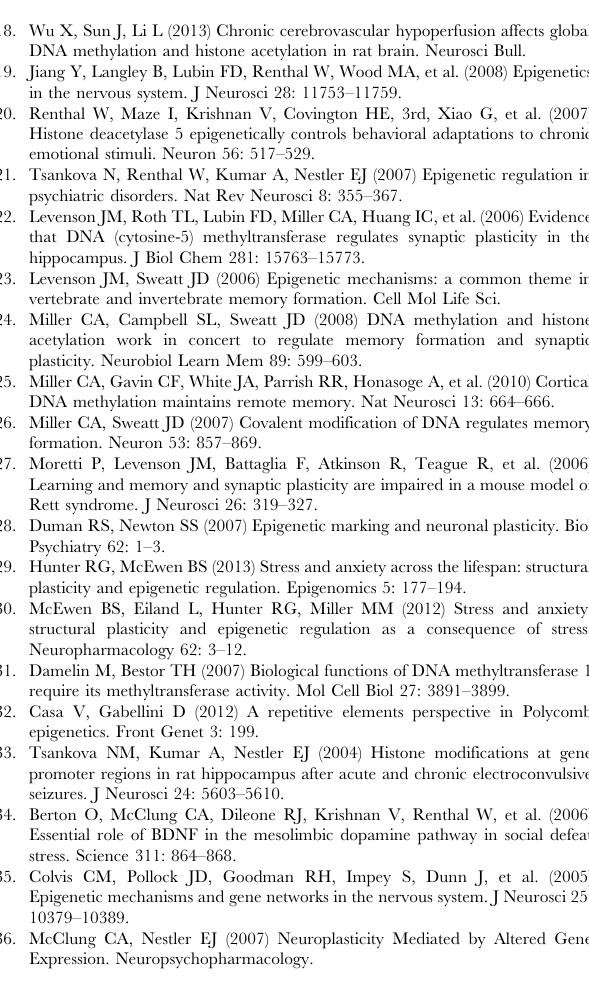
samples per group). The same samples were evaluated with Western blot detection of AcH3 levels. In all cases, results from Western blot agreed with those from flow cytometry. Figure S2 Technical replication of flow cytometry measurements. After performing flow on 20 samples from the hippocampus, samples were stored overnight and re-run. Mea- surements were highly correlated across flow cytometry runs (Pearson R= 0.95, p , 0.0001). Table S1 Spearman correlations of open-field behav- ioral measures across testing days. Table shows the Spearman-r values for the correlations between five open-field measures (percent distance in the center, total distance in the center, time spent in the center, entries into the center, and total distance travelled) on testing day 1 with behavioral measures from 2 subsequent testing days. Sessions 1 and 3 were conducted in direct light and session 2 was done in the dark to make the testing environment less anxiogenic. Results show there were significant correlations between nearly all measures on subsequent testing days and the behavior of mice on testing day 1. Results indicate that day 1 measurements predict stable individual differences in open-field behavior.